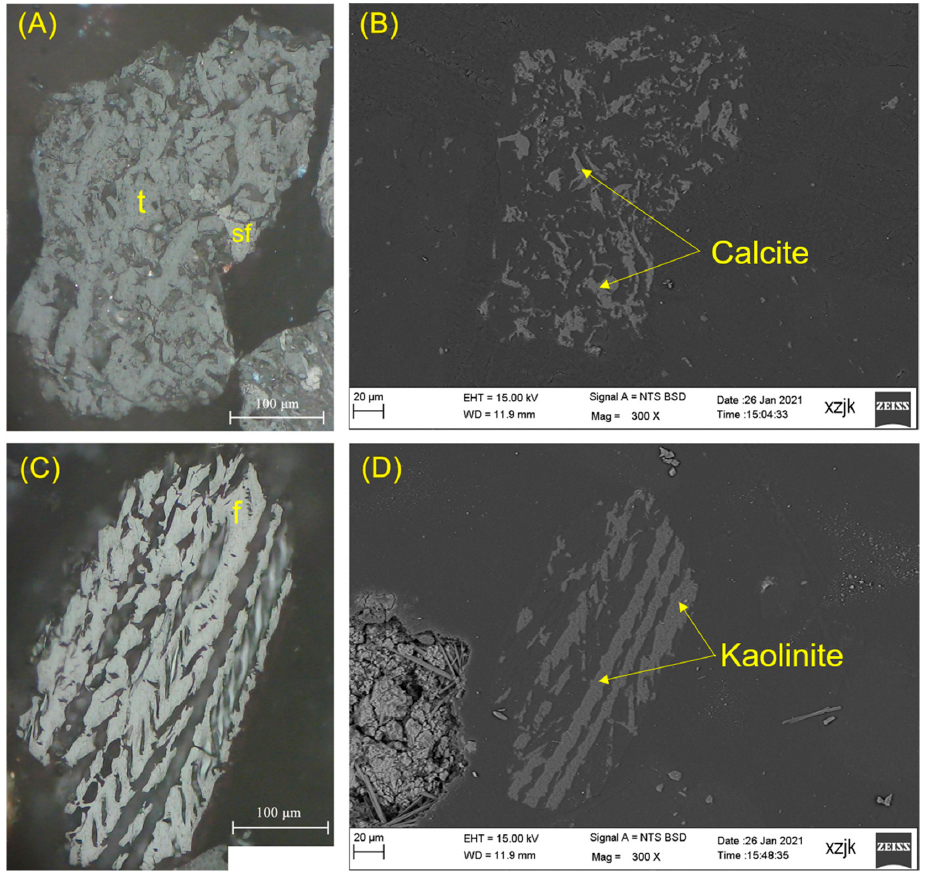
Figure 4. Microscope and SEM–EDS identification of DLTR: ( A ) A telinite (t) mixed with semifusinite (sf) fragment; ( B ) SEM–EDS image of ( A ); ( C ) A fusinite (f) particle; ( D ) SEM–EDS image of ( C ).